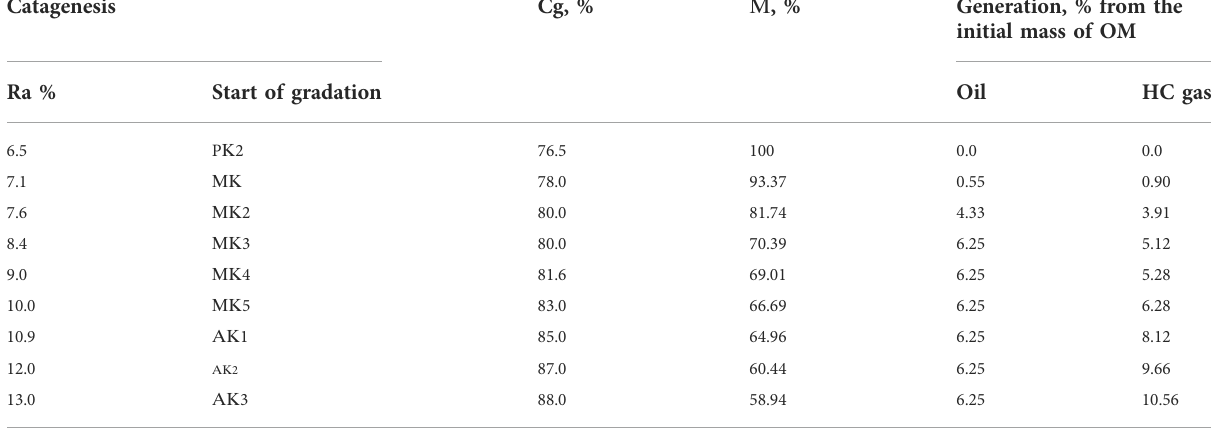
TABLE 5 Generation of oil, hydrocarbons, and other volatile components by low-concentration oxysorbosapropelic OM. Catagenesis Cg,